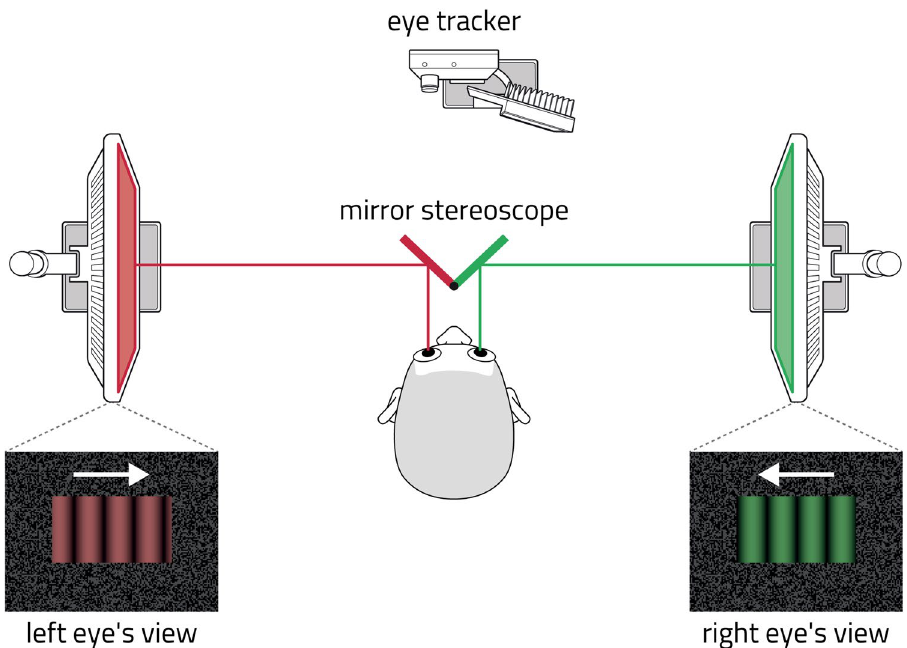
Figure 1. Binocular rivalry paradigm. Participants sat in a mirror stereoscope and viewed two separate displays with their left and right eyes. Displays showed gratings of different colour (red and green) and opposite motion, inducing occasional reversals of phenomenal appearance (binocular rivalry). Perceived appearance and its reversals were monitored objectively by recording optokinetic nystagmus of one eye (OKN), using an automated analysis 46